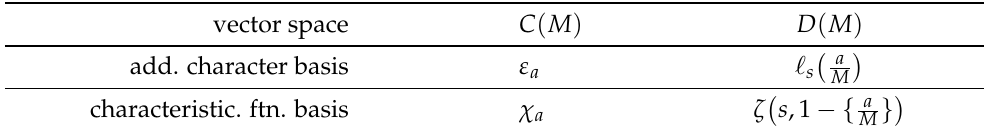
Table 2. Vector spaces and their